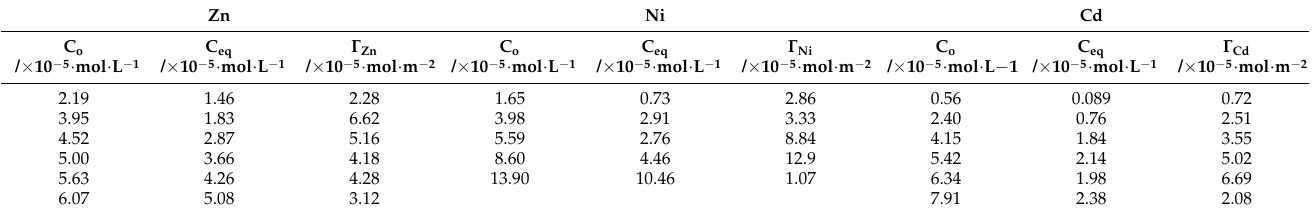
Table 8. Initial concentrations, C o ; equilibrium concentration, C eq ; and surface concentration, Γ , for each metal adsorption on calcite. (Ionic strength of 0.15 M of NaCl). Zn Ni Cd